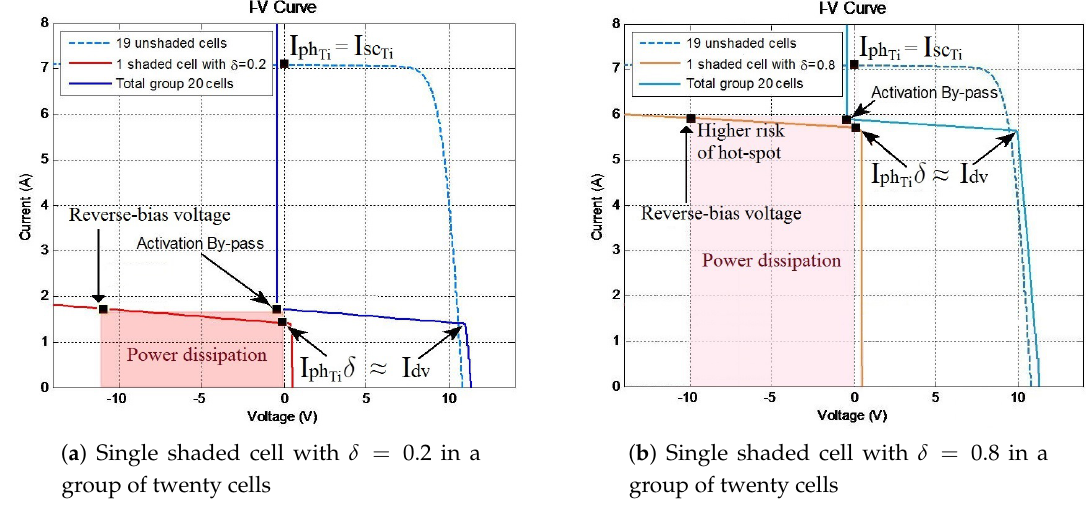
( a ) Single shaded cell with δ = 0.2 in a ( b ) Single shaded cell with δ = 0.8 in a group of twenty cells Figure 6. Influence of δ in a group of twenty cells with a single shaded